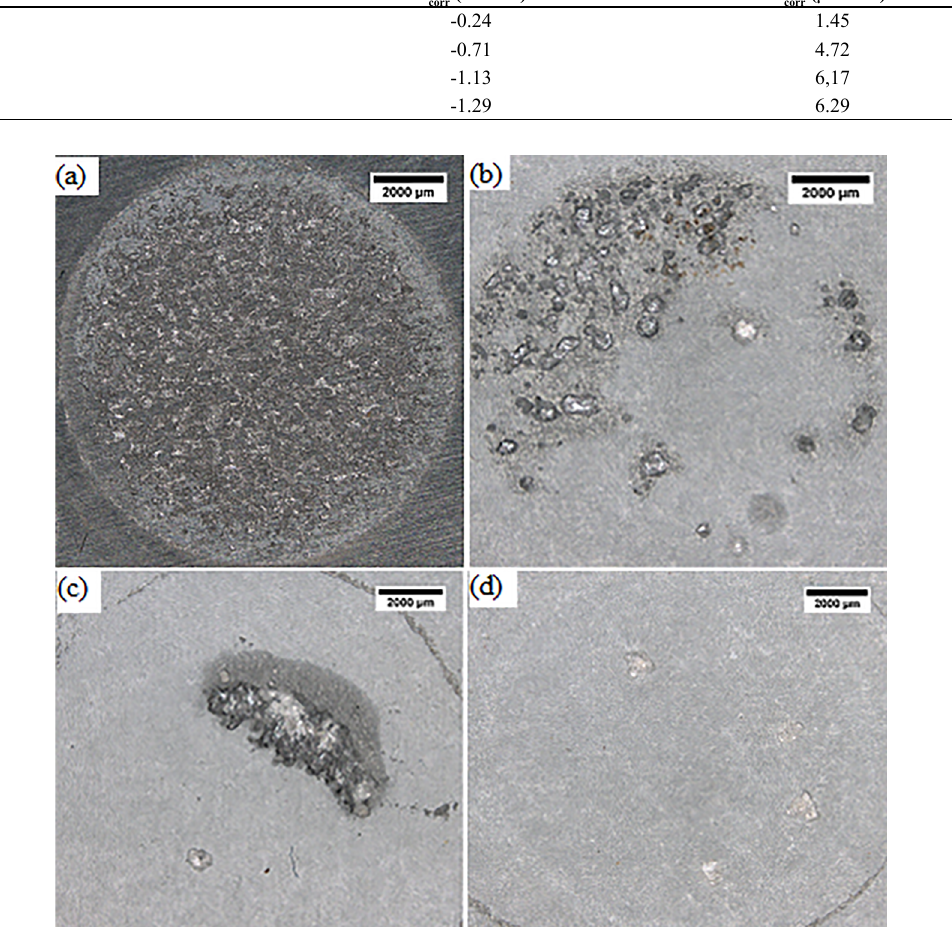
Table 2. Corrosion potential (E obtained by Tafel extrapolation.